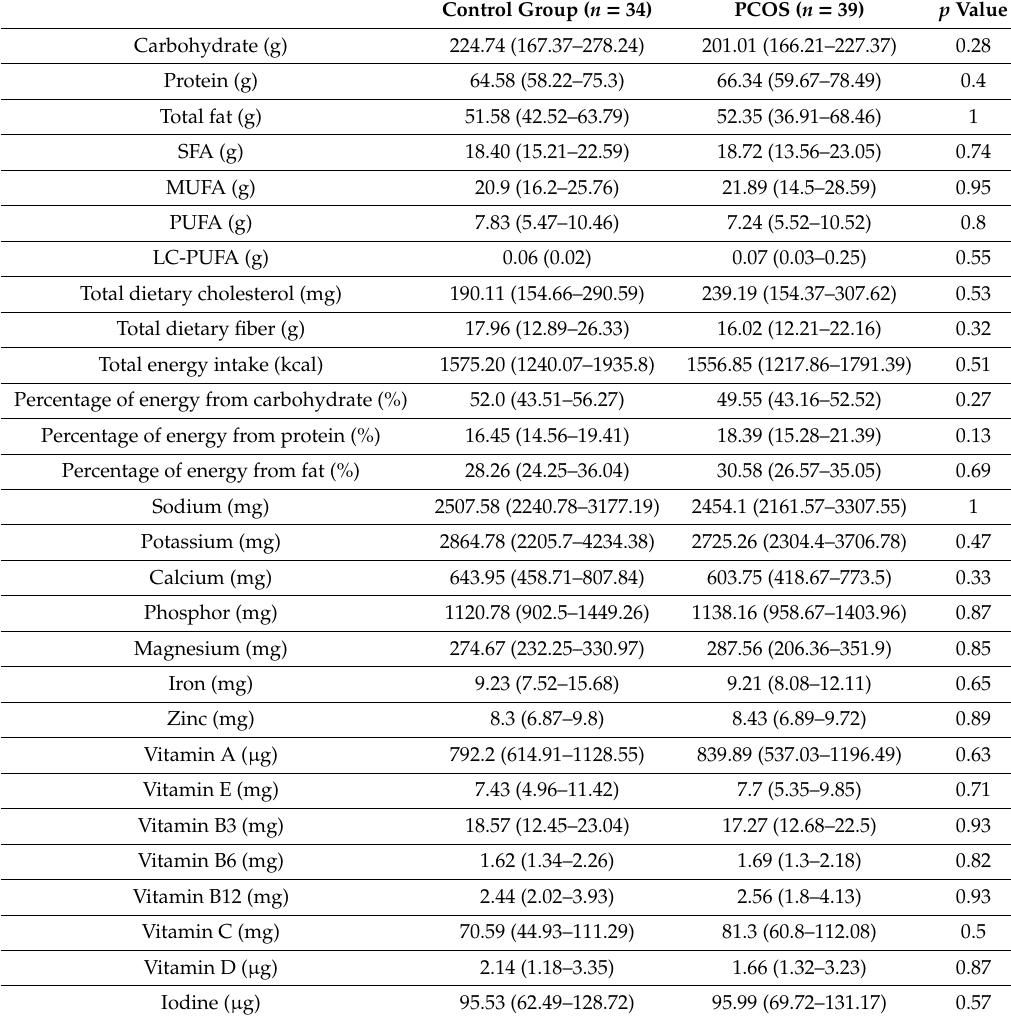
Table 2. Macronutrient and micronutrient intake in the studied